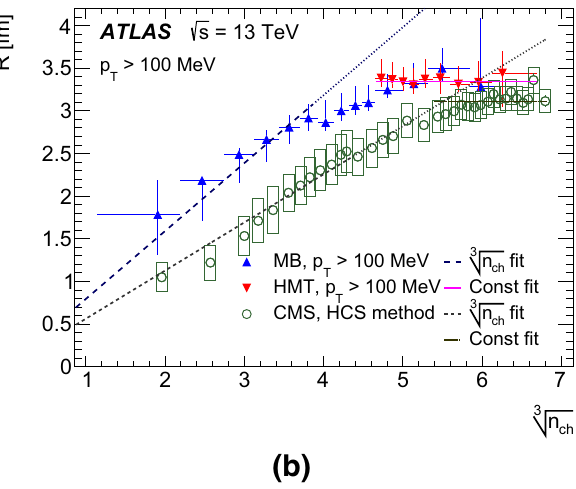
Fig. 15 ATLAS and CMS results for the source radius R as a function √ n ch in pp interactions at 13 TeV. The CMS results of a n ch and b 3 (open circles) have been adjusted (by the CMS collaboration) to the ATLAS kinematic region: p T > 100 MeV and | η | < 2 . 5. The ATLAS uncertainties are the sum in quadrature of the statistical and asymmet- ricsystematicuncertainties.ForCMS, onlythesystematicuncertainties